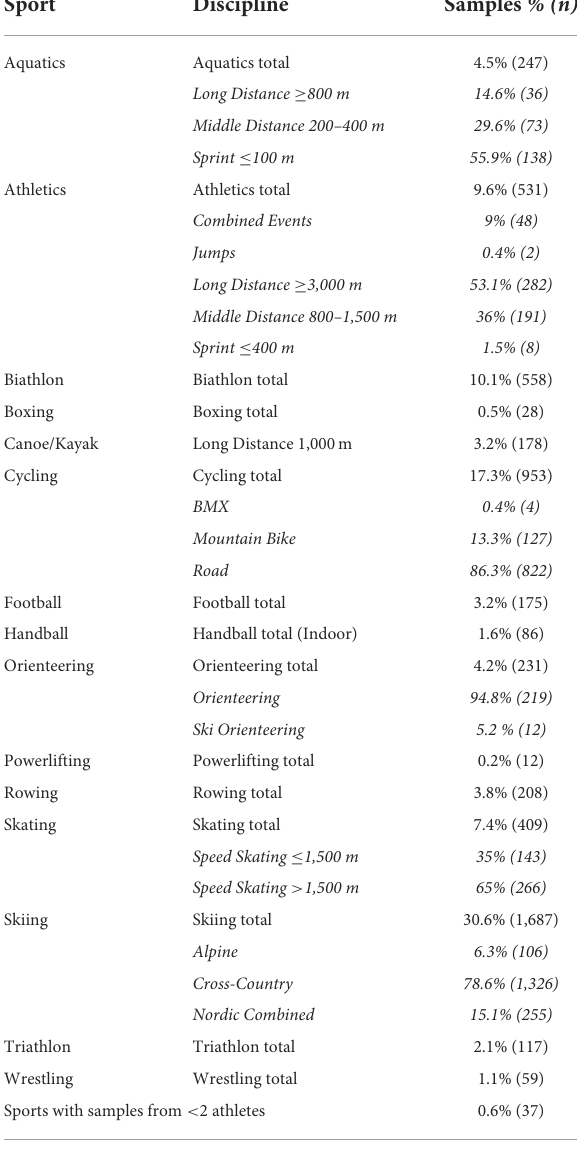
TABLE 3 Number of hematological ABP samples collected in 2010–2019 by sport and